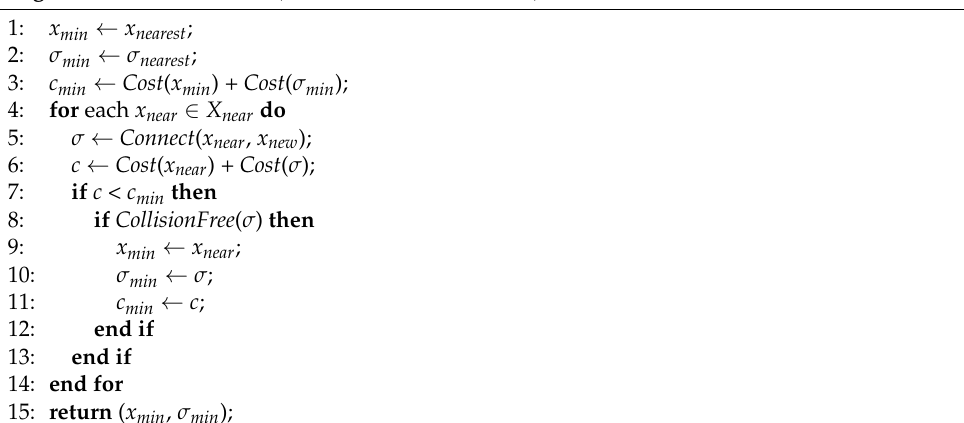
Algorithm 2 ChooseParent( X near , x nearest , x new , σ nearest